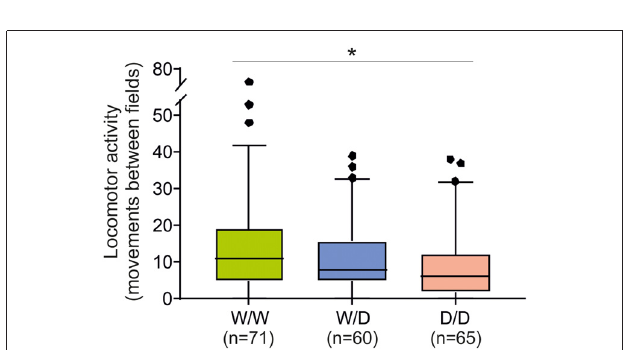
FIGURE 3 | Righting response of newly hatched chicks of three genotypes (W/W, W/D and D/D). The time required to right was not significantly different between chicks of the three genotypes. Box plots show medians, first and third quartiles and whiskers with outliers outside the 5th and 95th percentiles.